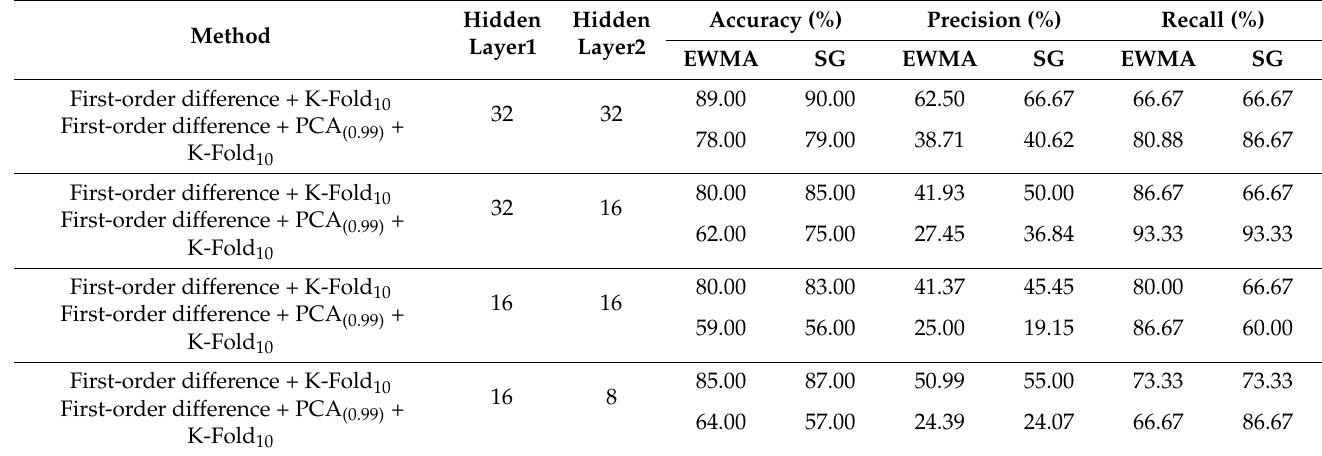
Table 3. Weighted binary cross entropy.